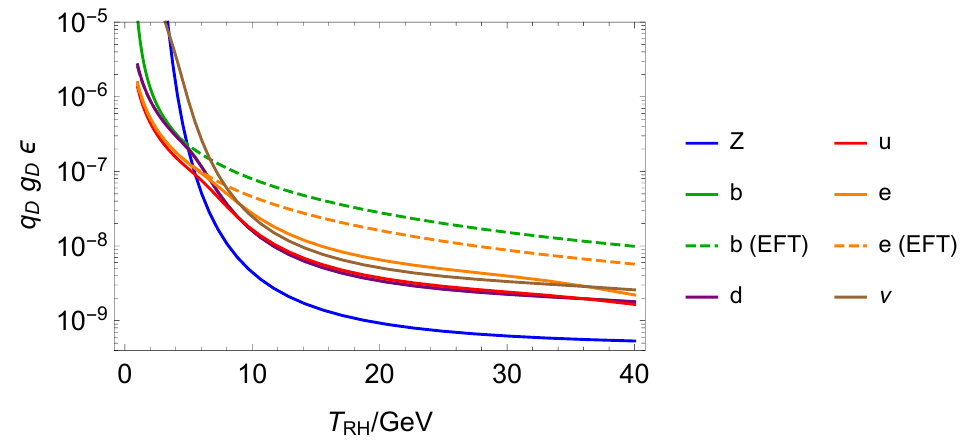
Figure 4 . Relative contributions of various channels for a Z 0 mediator that kinetically mixes with the SM hypercharge, for m Z 0 = 500 GeV, m X = 1 GeV. We include both the Z and Z 0 mediated diagrams. We only show a subset of the EFT (non-resonant) contributions, for the bottom quark (dashed green) and the electron (dashed orange). For illustrative purposes, we also include the contribution from the Z decay. The decay contribution from a thermal Z 0 population does not feature on this plot as it is independent of (cid:15) at leading